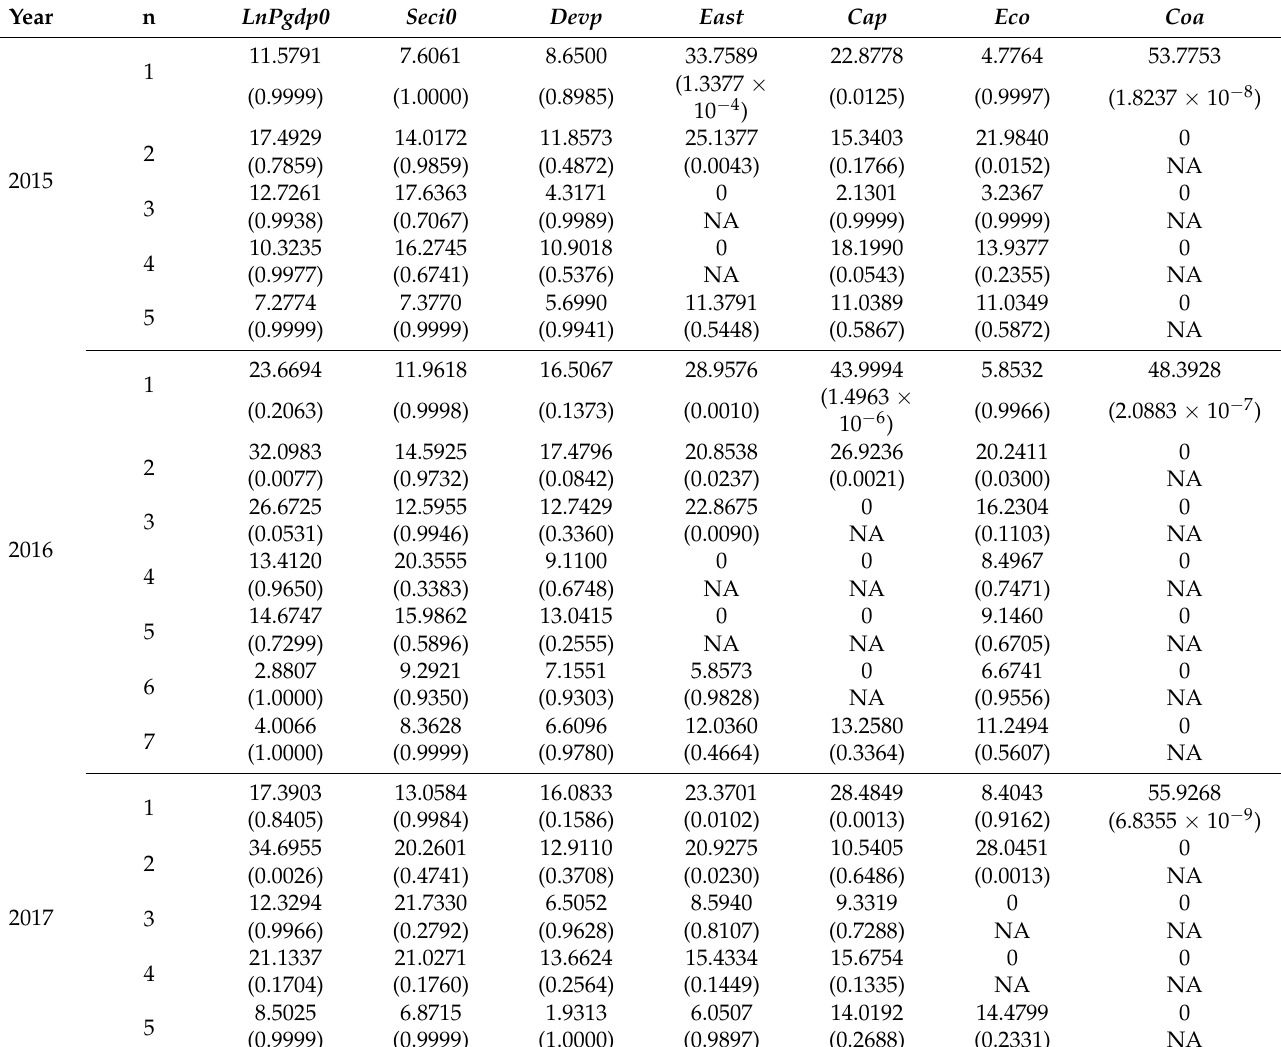
Table 4. Results of the parametric stability test for the period